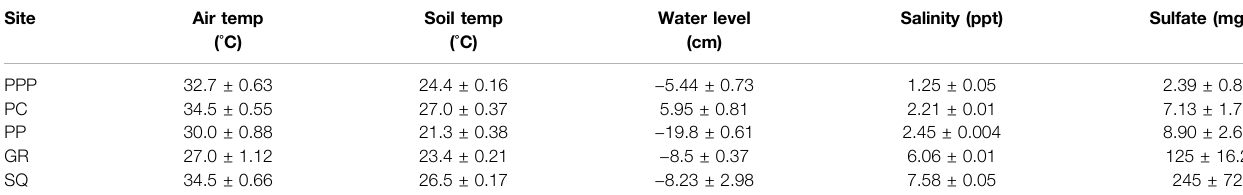
TABLE 1 | Environmental conditions (mean ± SE) during sampling across all sites. GR and PP were sampled in June 2019 while PPP, PC and SQ were sampled in July 2019.Water level and salinity values were averaged from the 3 days leading up to sampling. Sulfate samples were taken from porewater sippers. Site Air temp ( ° C)